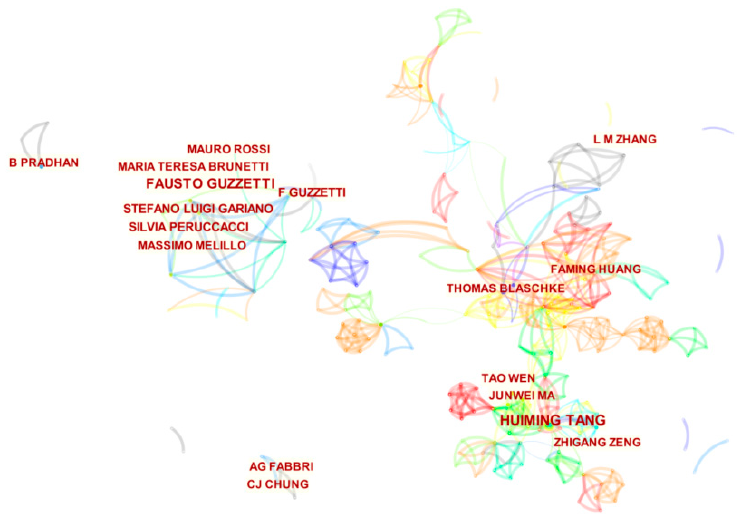
Figure 6. Author collaboration network knowledge graph.